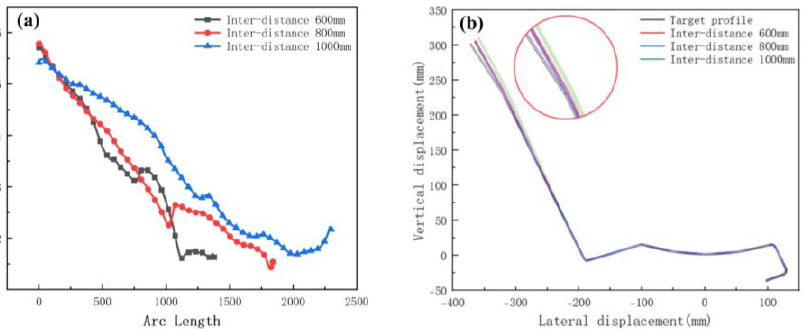
Figure 12. ( a ) Displacement X of strip in 3 inter-distance conditions; ( b ) cross-section of 3 inter- distance